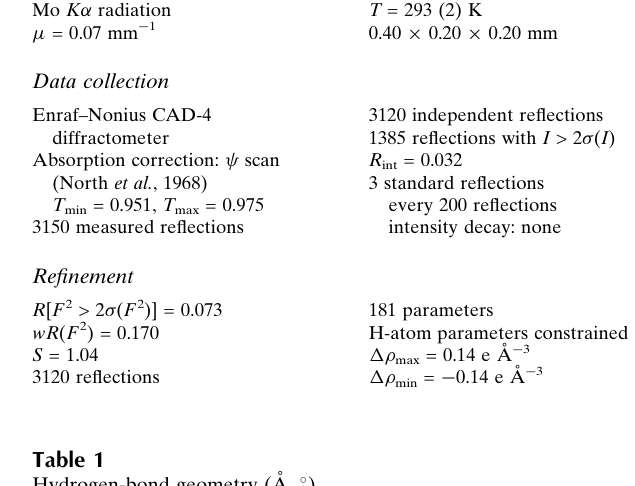
Hydrogen-bond geometry (A˚ , (cid:1)